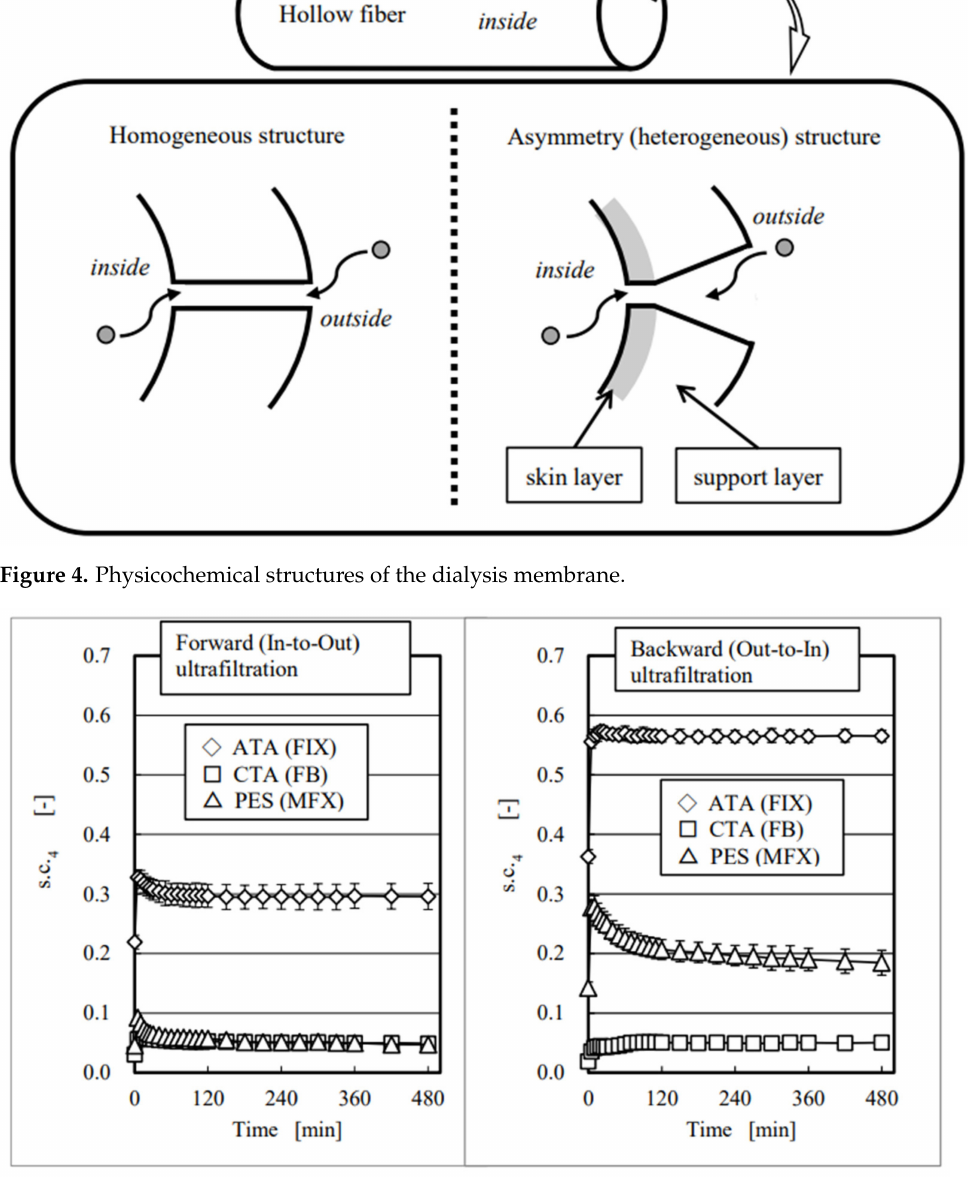
Figure 5. Time courses of the sieving coefficient for albumin in three investigated